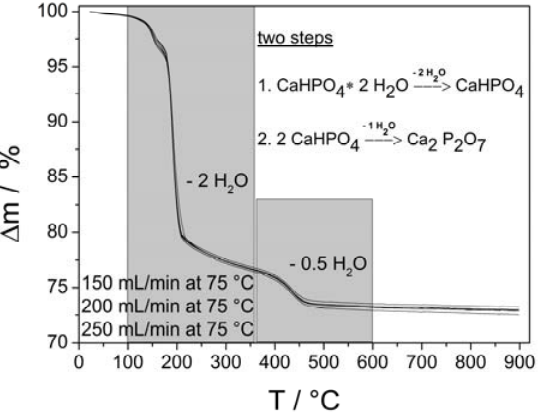
Figure 12. Thermal decomposition of the obtained material. The decomposition takes place in two steps, which is typical for the thermal decomposition of calcium hydrogen phosphate in the brushite phase.